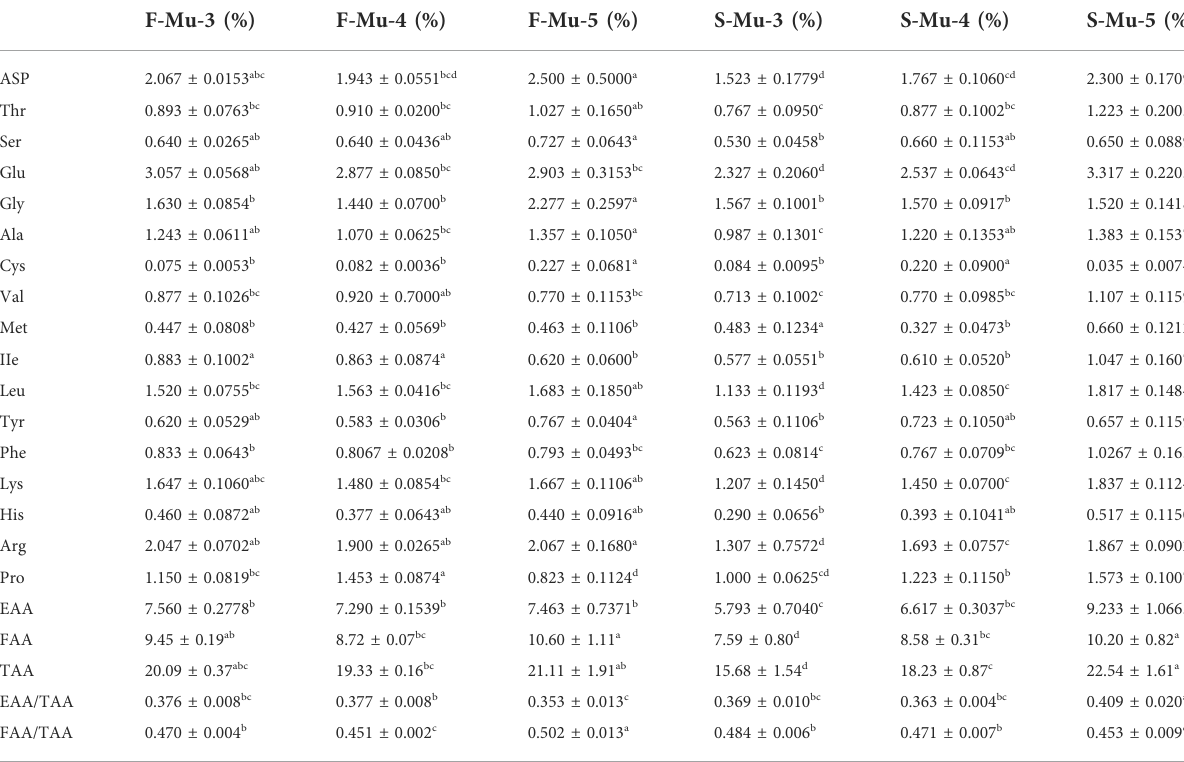
TABLE 7 Pro fi le of amino acids in female Scylla paramamosain muscle during the two vitellogenesis